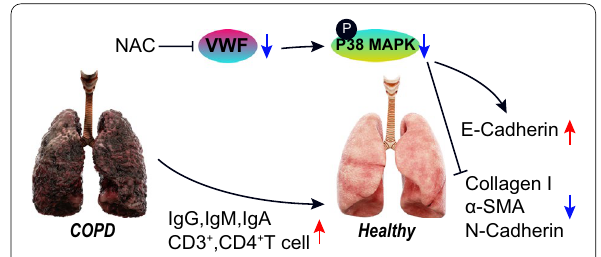
Fig. 8 Antioxidant NAC promotes the immune response to improve COPD-induced pulmonary fibrosis by inhibiting the VWF/p38 MAPK/ EMT